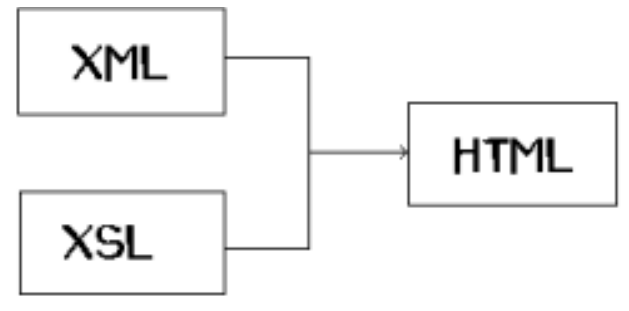
Figure 7: XML and XSL merge to create